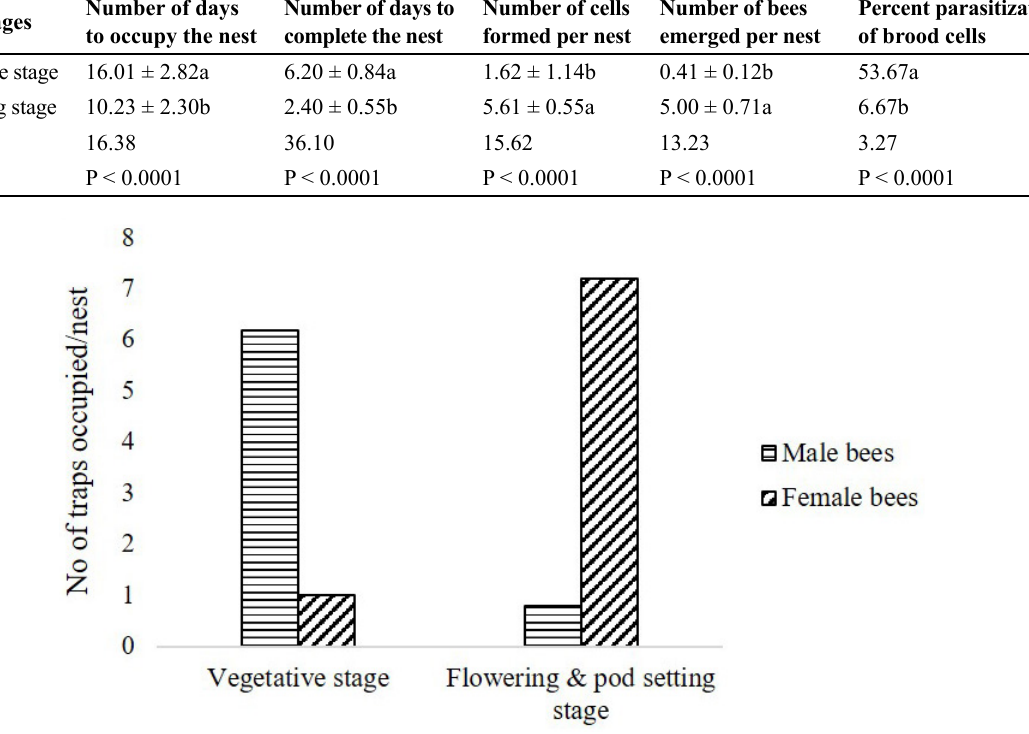
Fig 4 . Number of traps occupied by male and female bee Megachile Latreille, 1802 at two different crop stages of Pigeon pea ( Cajanus cajan (L.) Millsp. Fabaceae) plantation of the experimental farm of ICAR- National Bureau of Agricultural Insect Resources (NBAIR) Bengaluru, Yelahanka Campus, India.